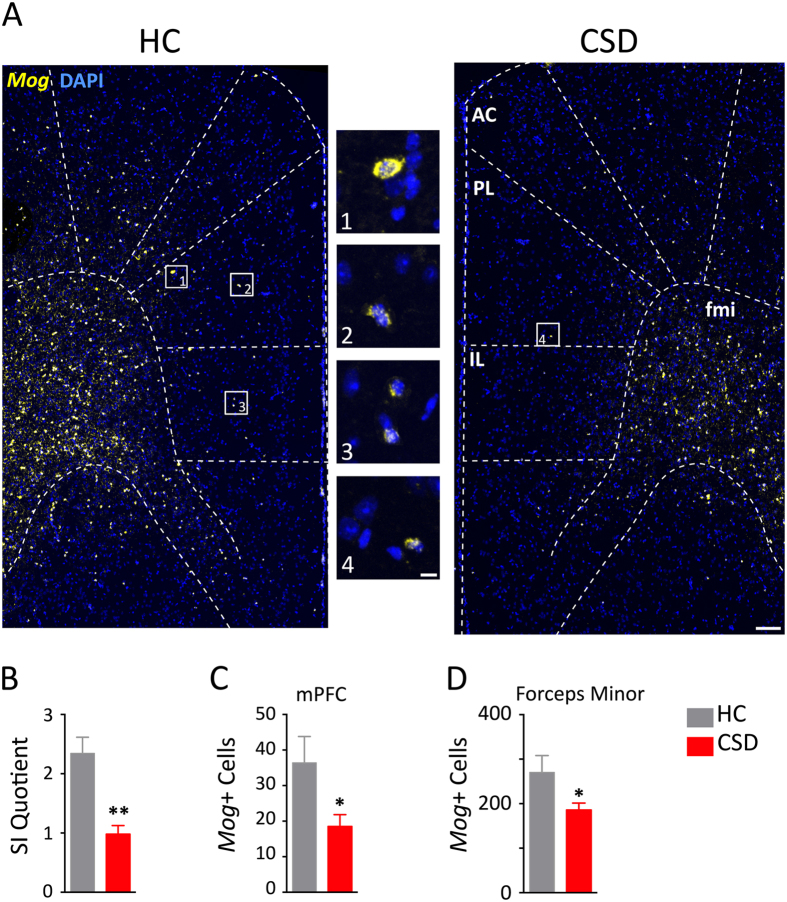
CSD reduced the expression of myelin oligodendrocyte glycoprotein (Mog) mRNA.(A) Representative fluorescent micrographs of Mog expression show comparative differences between HC and CSD frontal cortices. Dashed lines indicate anatomical regions and templates within which counts were made. The medial prefrontal cortex (mPFC) was defined by the anterior cingulate (AC), prelimbic (PL), and infralimbic (IL) cortices. fmi, forceps minor corpus callosum. Scale bars = 100 μm and 20 μm for low- and high-magnification photographs, respectively. (B) CSD mice showed markedly reduced social interaction (SI). CSD significantly reduced the number of Mog-positive cells in the mPFC (C) and fmi (D). Results are expressed as mean ± SEM (n = 5 per group). Unpaired two-tail t-test: *p < 0.05, **p < 0.005.